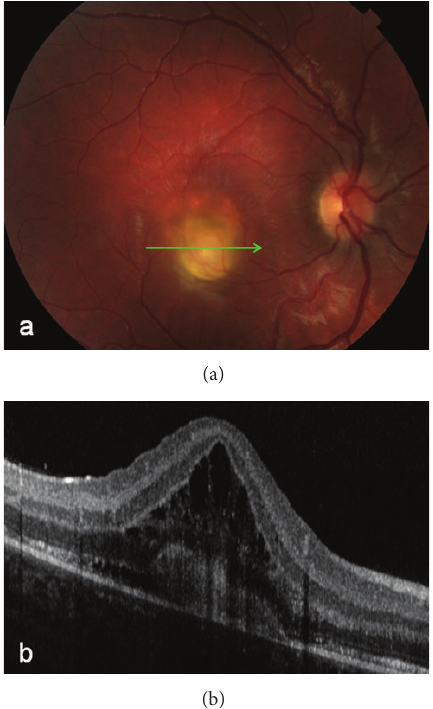
Figure 2: (a) The color fundus of the right eye shows a yellowish materialatthecenterofthemacula.(b)SD-OCTdetects“vitelliform material” underlined by intraretinal cystic cavities and subretinal